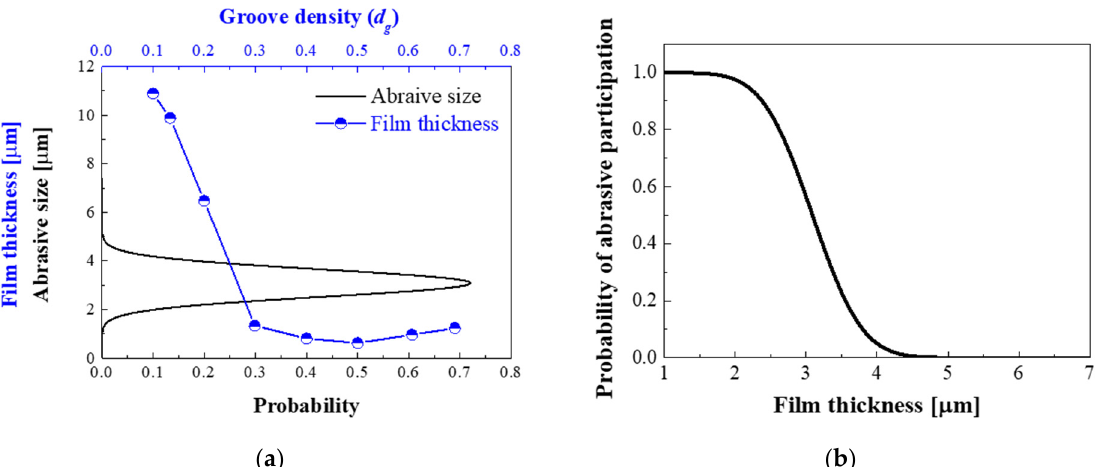
Figure 14. ( a ) Relation between film thickness and abrasive size; ( b ) probability of abrasive participation as a function of film thickness.